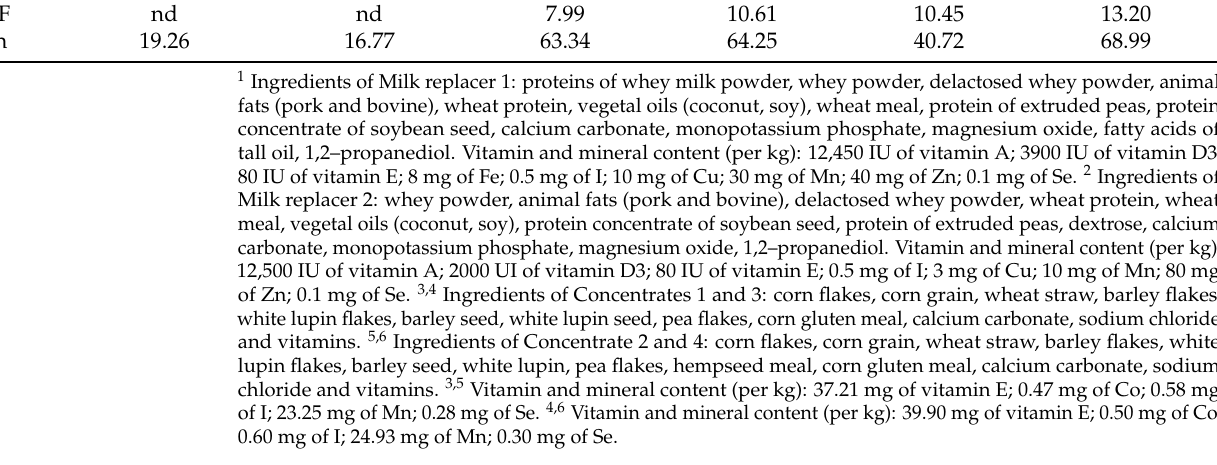
Table 3. Fatty acid profile (g/100 g of FAME 1 ) of the